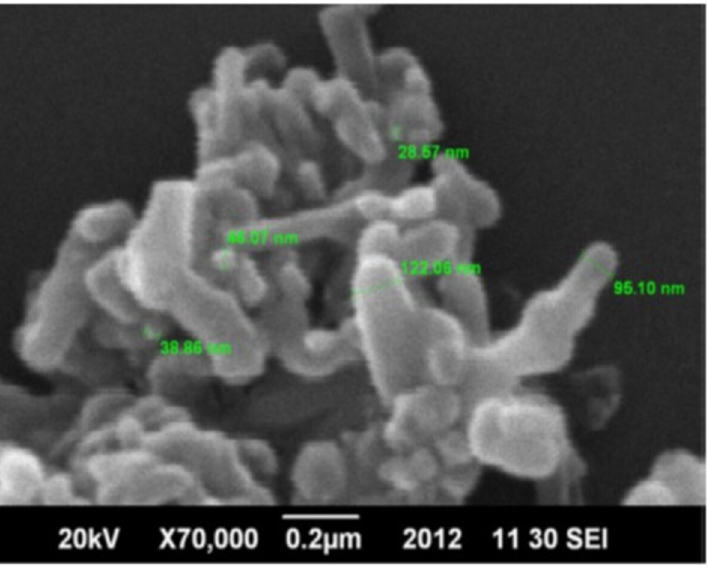
Figure 11. SEM image showing the nanostructure of hydroxyapatite prepared by the microwave irradiation technique [166].